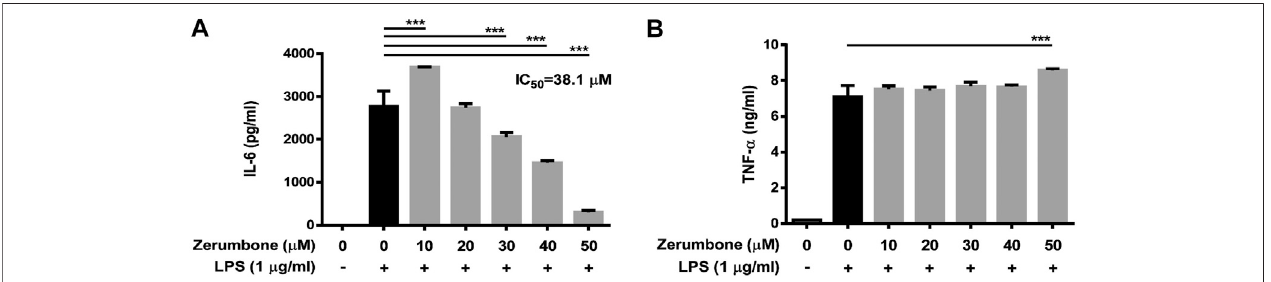
FIGURE 2 | TheeffectsofzerumboneontheproductionofIL-6andTNF- α inLPS-activatedJ774A.1cells.Cellswerepre-treatedwithvariousdosesofzerumbonefor1 h followingtreatmentofLPS(1 μ g/ml)for24 h.Cellsupernatantswerecollectedandthelevelsof (A) IL-6and (B) TNF- α wereanalyzedusingELISA.Datawerecollectedintriplicate and represented as means ± SD. Statistical signi fi cance between the zerumbone-treated groups vs. the LPS-only group is represented as follows: *** p <